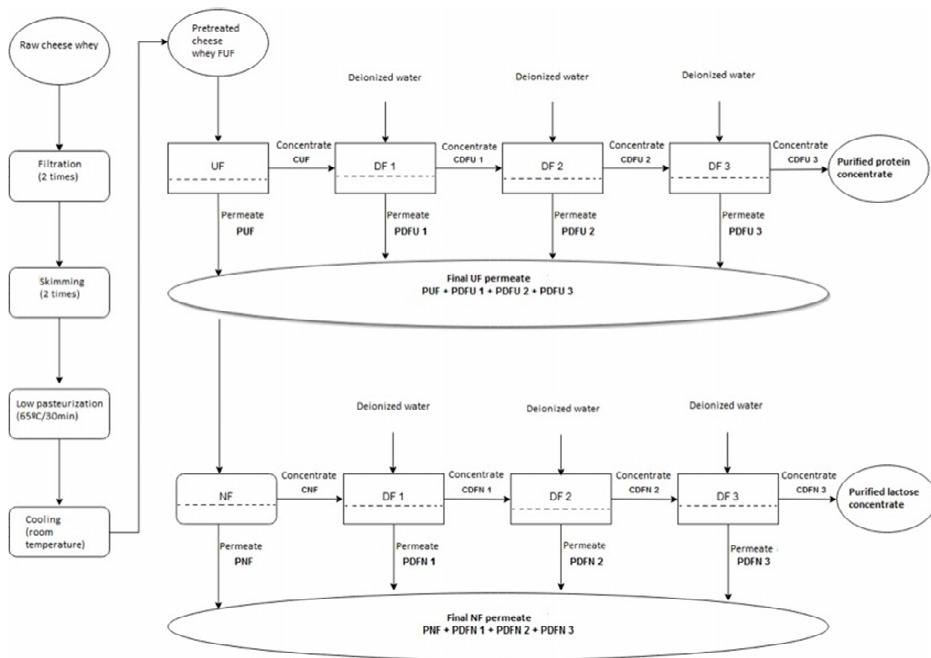
Figure 1. Experimental scheme.